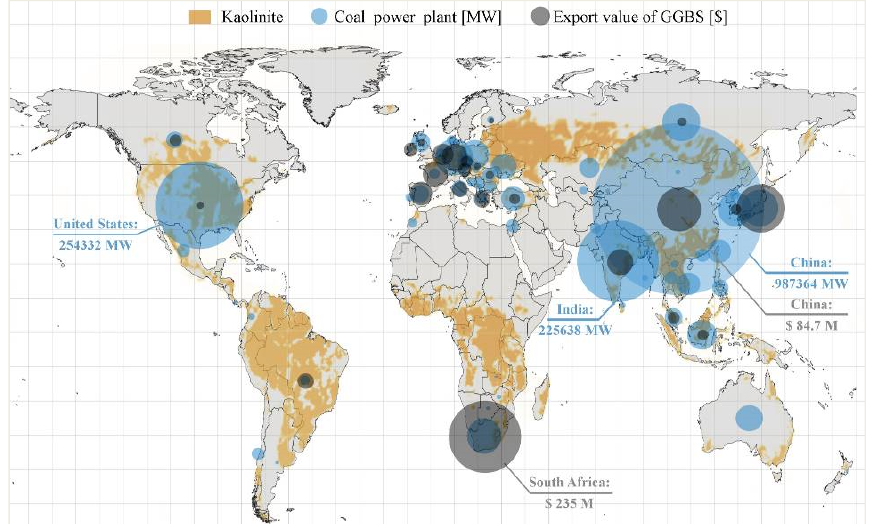
Fig. 1. Map displaying the worldwide availability of the raw materials used for AAM production. For coal power plants, the area of each bubble is proportional to the capacity in MW of the power plant. For GGBS the area of each bubble is proportional to the economic value associated with the export of